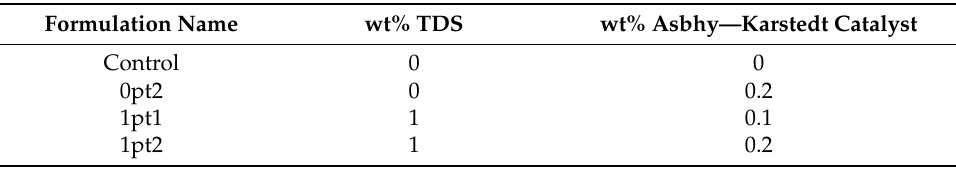
Table 1. The formulations of Sylgard 184 used in this